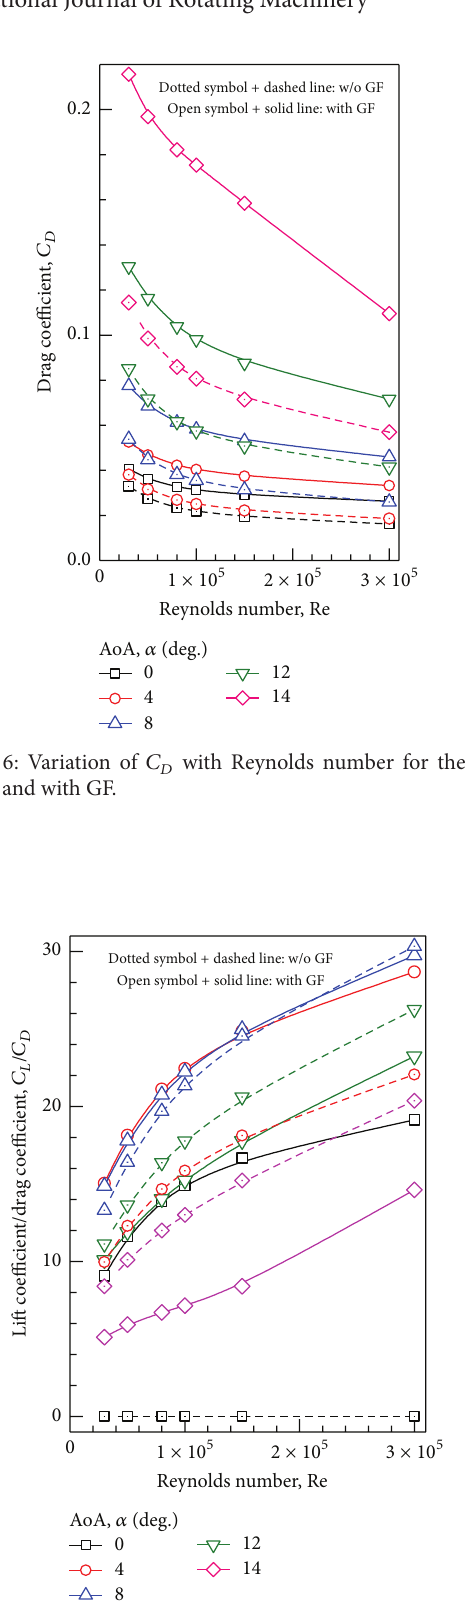
Figure 9: Static pressure distributions for different Reynolds num- bers at AoA = 12 ∘ for the airfoil without and with